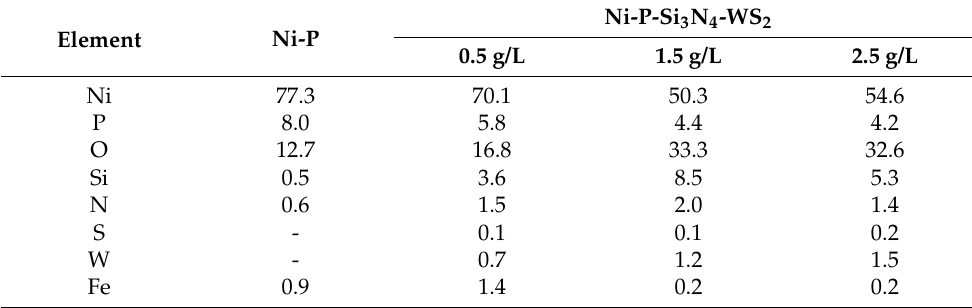
Table 3. Chemical composition of wear mark (mass fraction).